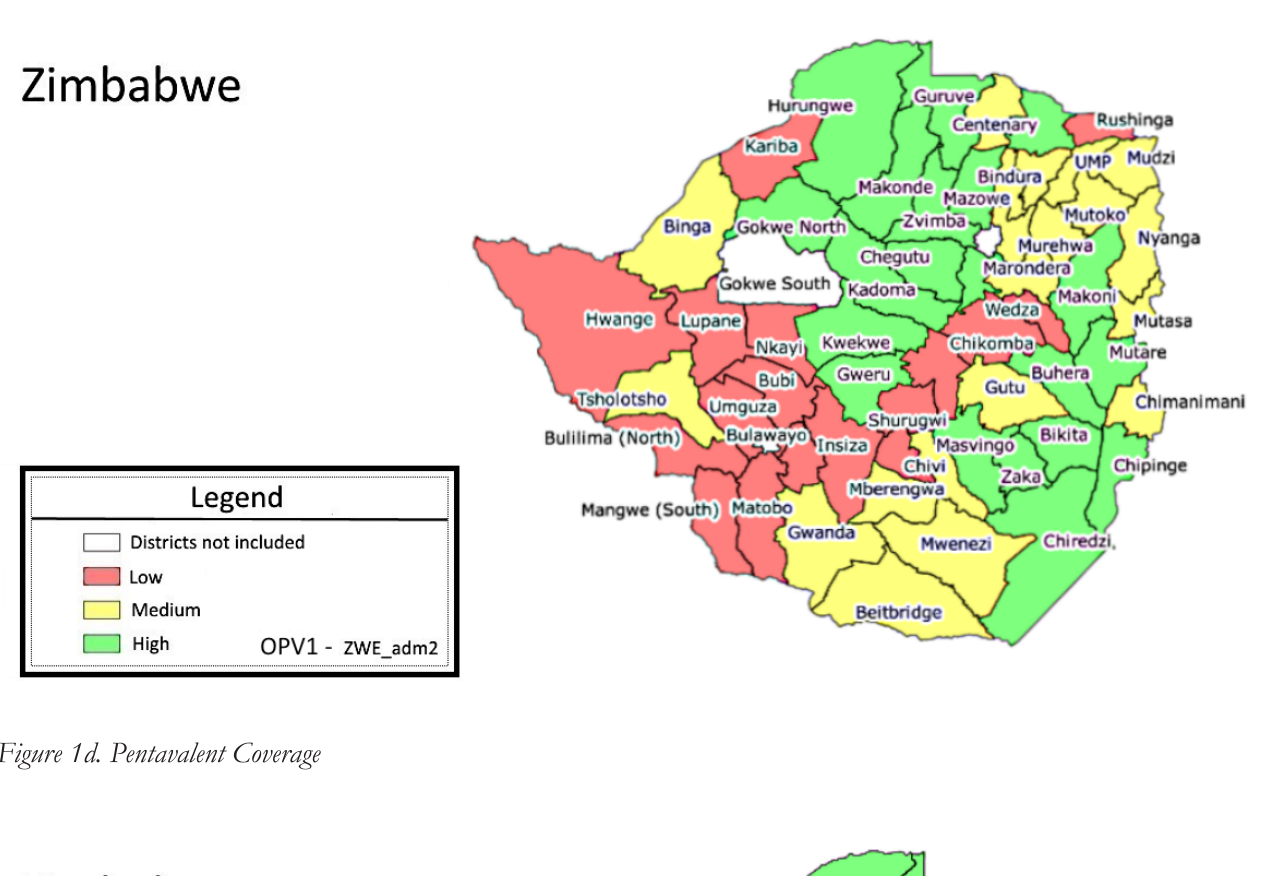
Figure 1c. Oral Polio Vaccine Coverage